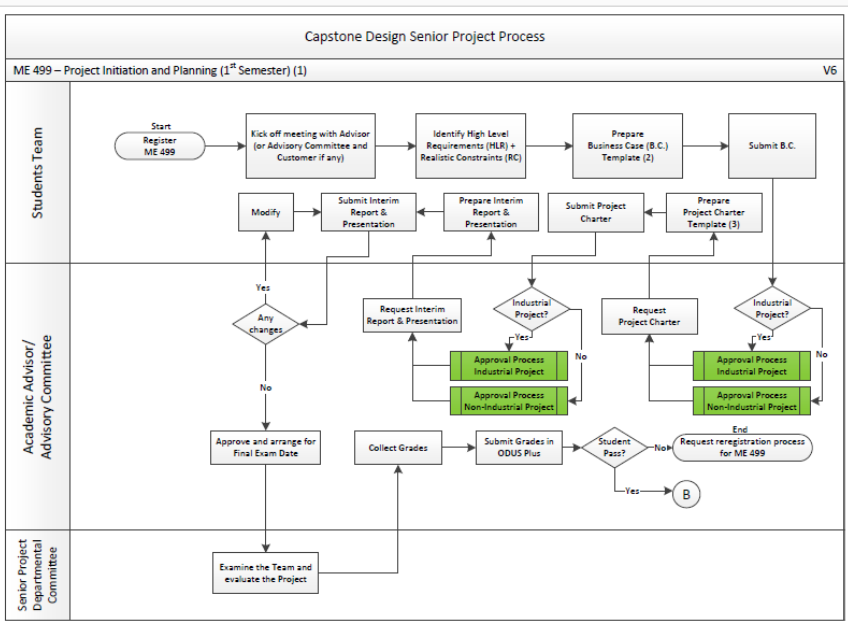
Fig. 3. Flow chart for Senior Project Design I